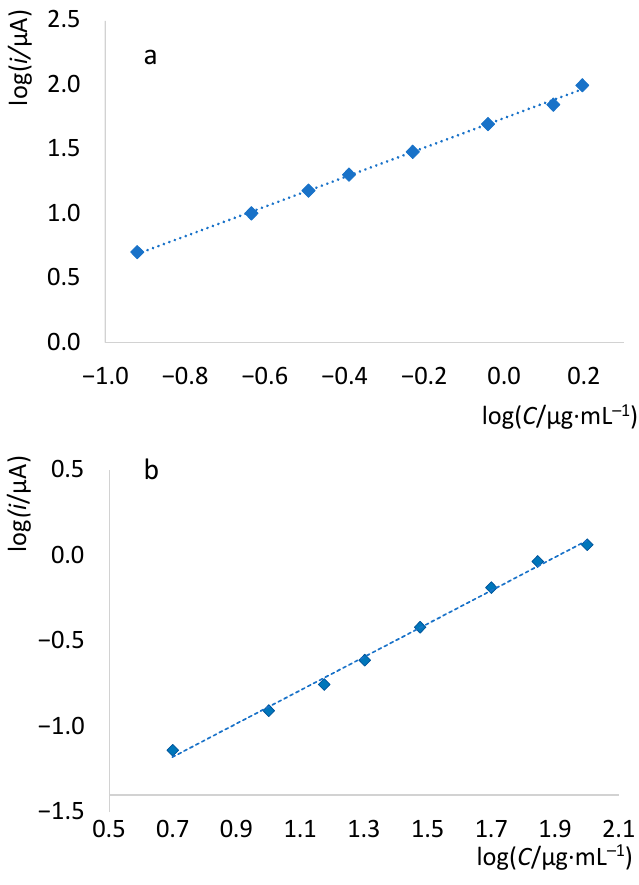
(Figure 6) and i p · ν − 1/2 vs. ν (Figure 7).